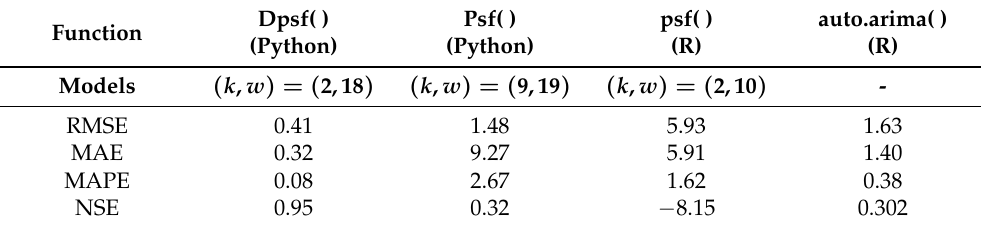
Table 4. Comparison of forecast methods with different error metrics for the “CO 2 ”